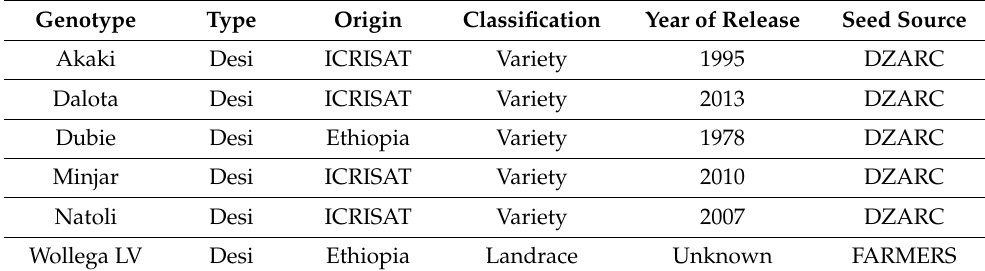
Table 1. Descriptions of chickpea genotypes used in the optimization experiment. Genotype Type